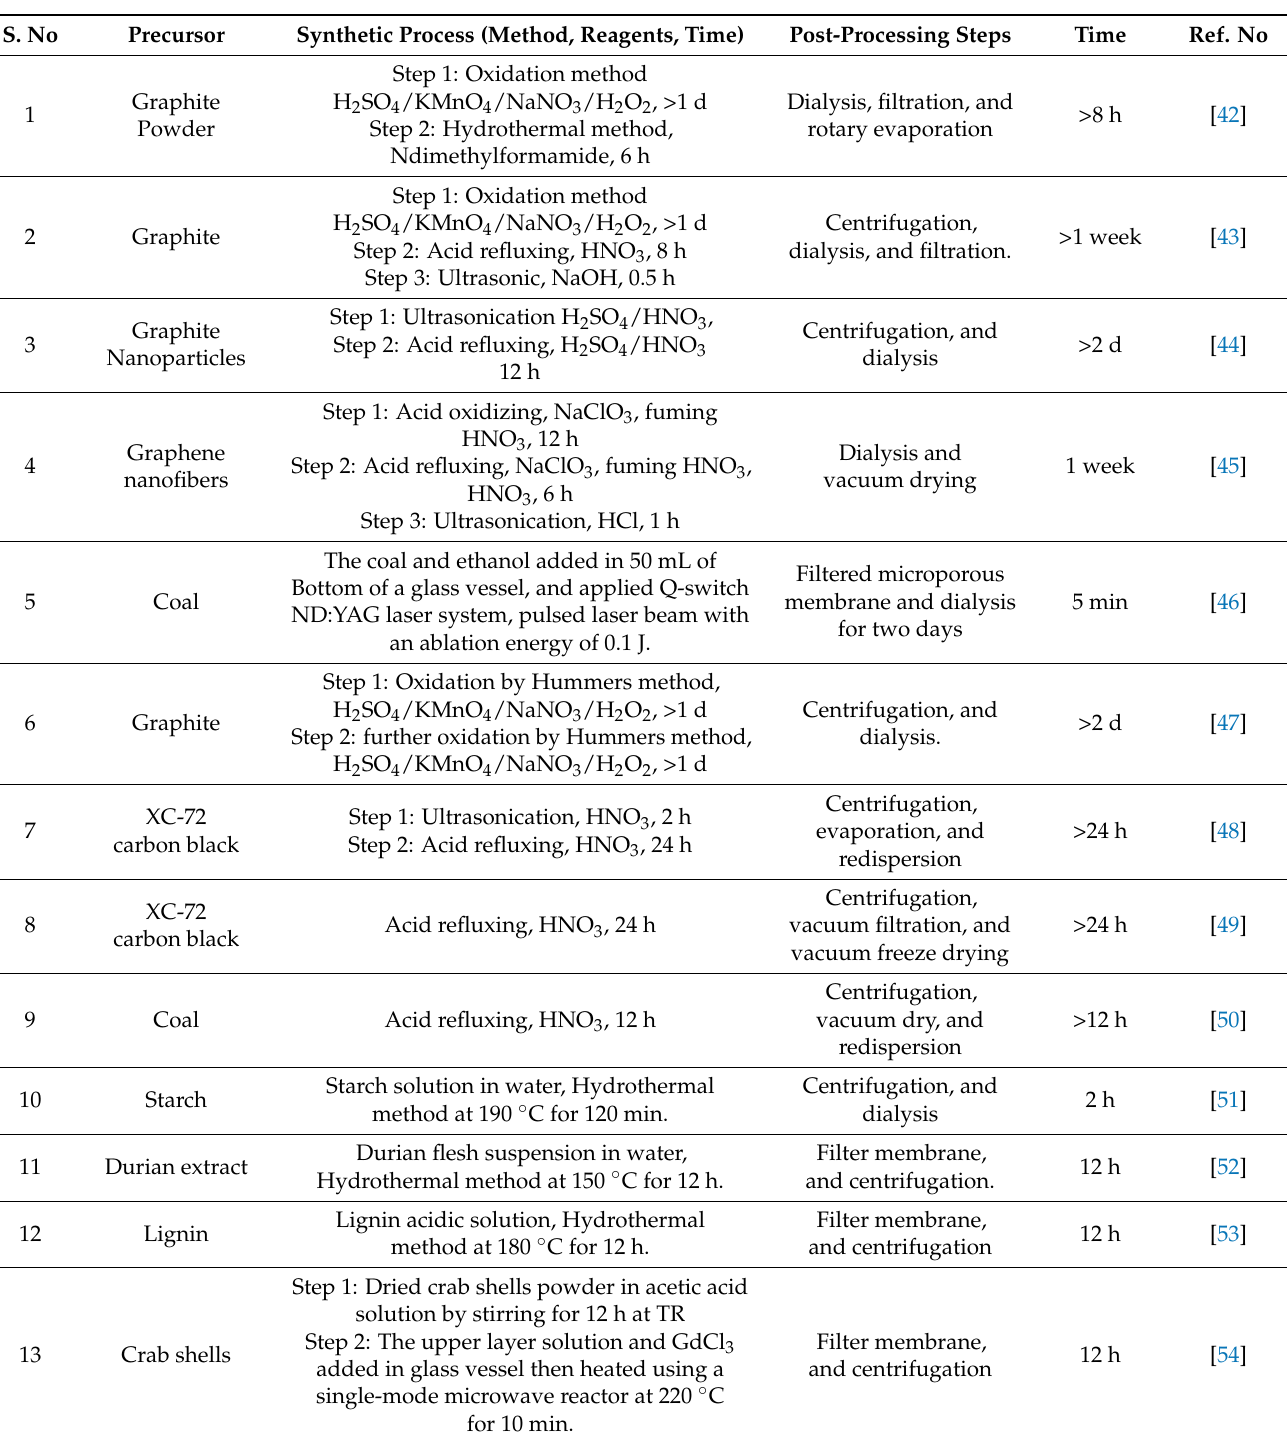
Table 1. Methods for synthesizing